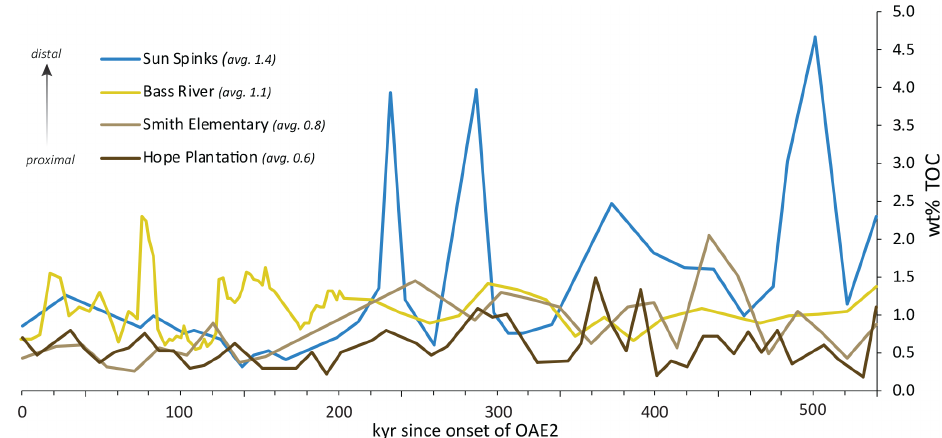
Figure 8. Comparison of measured wt% TOC for the duration of OAE2 for the Sun Spinks core in Mississippi, the Bass River core in New Jersey, and the Smith Elementary School and Hope Plantation cores in North Carolina. The age model is based on the thickness of the OAE carbon isotope excursion and the orbitally tuned duration of OAE2 at the Global Stratotype Section and Point in Pueblo, CO (Sageman et al., 2006; Meyers et al., 2012) of 540kyr, assuming a constant sedimentation